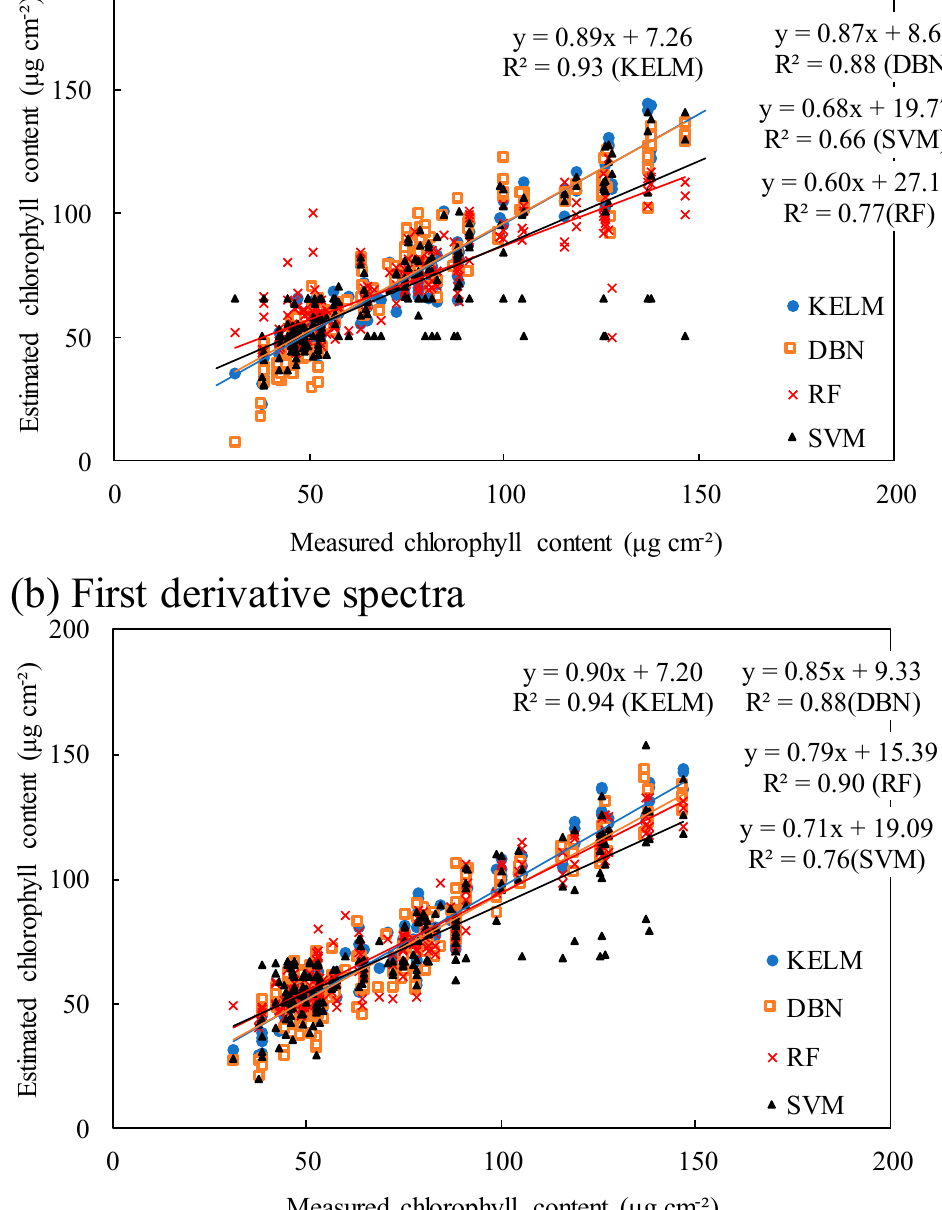
Figure 5. Relationships between estimated and measured chlorophyll contents.